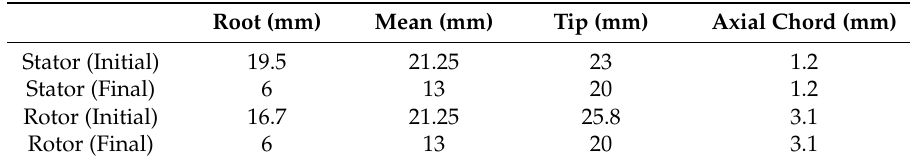
Table 6. Measurements regarding the initial and final blade profile heights and axial